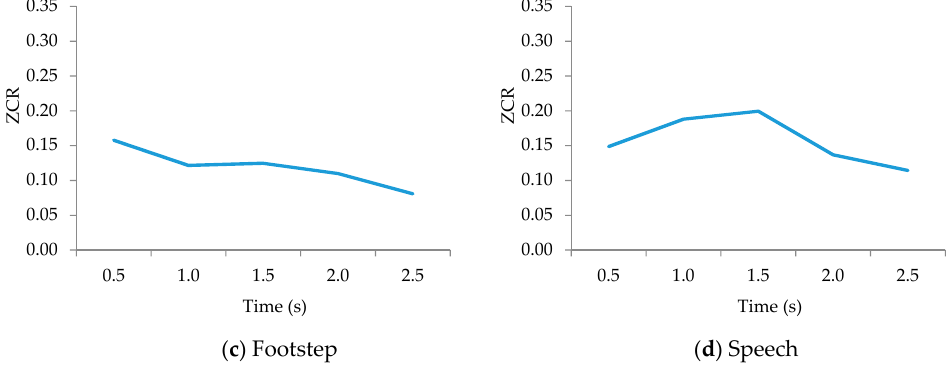
Figure 6. STZCR patterns of four sound-events ( a – d ).